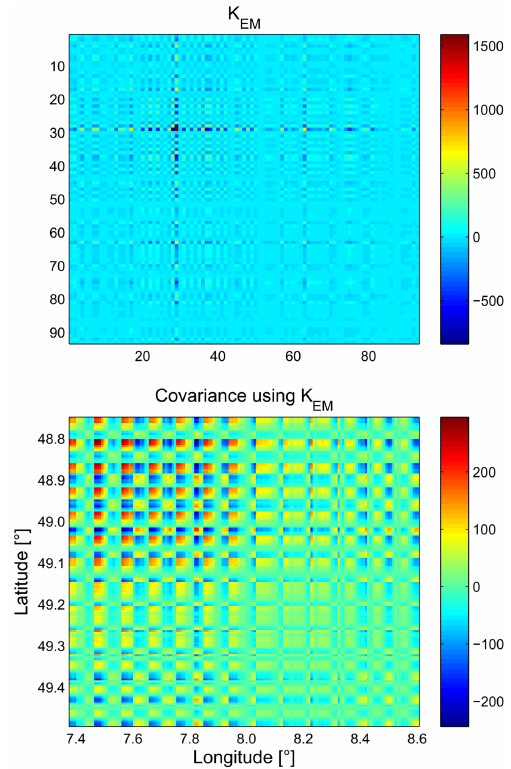
Figure A1. Estimate of the covariance matrix K using the E–M al- gorithm and the corresponding covariance matrix for the wet delay map from PSI+GNSS. The wet delay observations are aggregated into maps of 7 × 7km 2 cells before their covariance matrices are